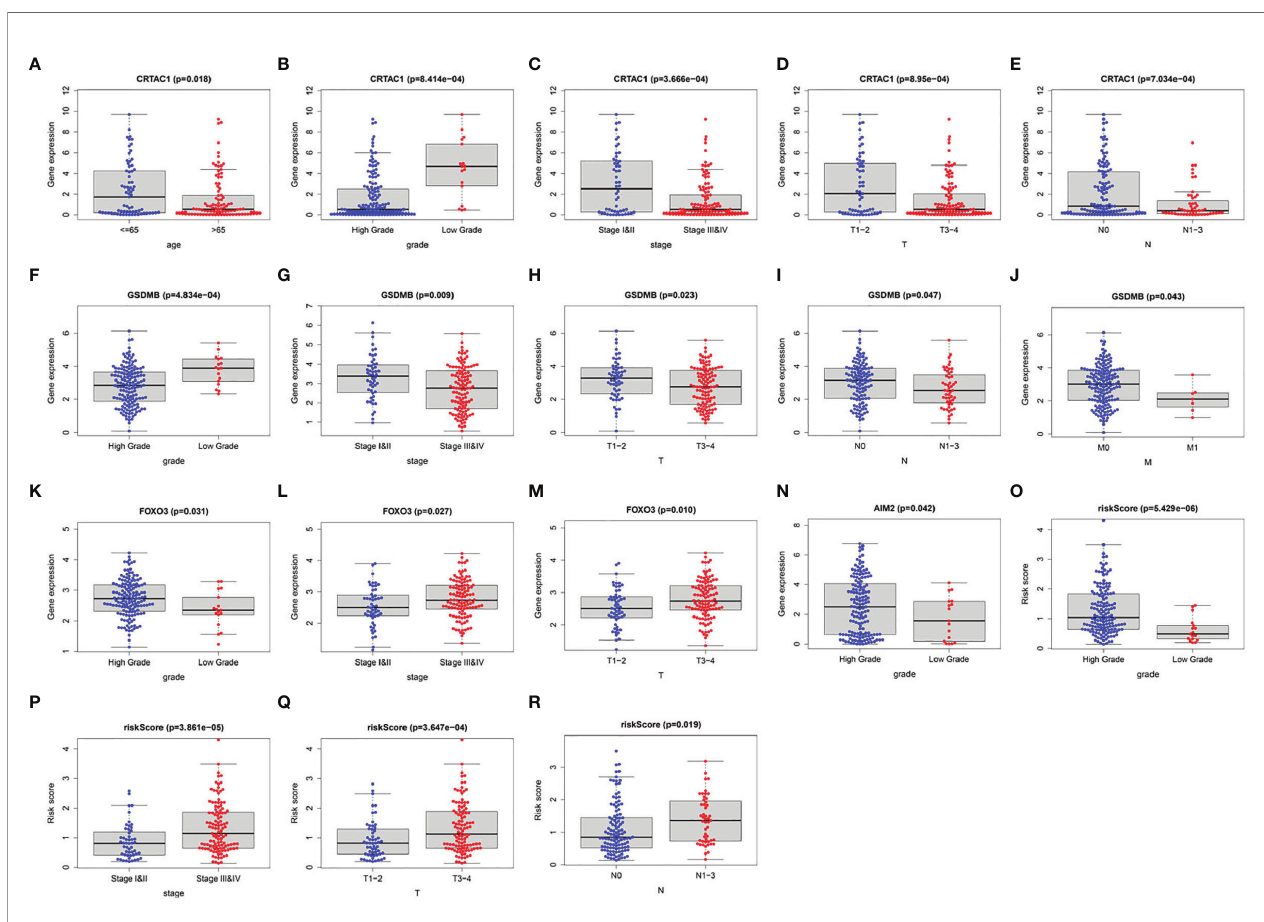
FIGURE 8 | The clinical relevance analysis in BLCA. (A – E) CRTAC1 expression in ages, grade, pathological stages, pathological T and N stages. (F – J) GSDMB expression in grade, pathological stages, pathological T, N, and M stages. (K – M) FOXO3 expression in grade, pathological stages, pathological T stages. (N) AIM2 expression in grade. (O – R) Risk scores expressed in grades of pathological T and N